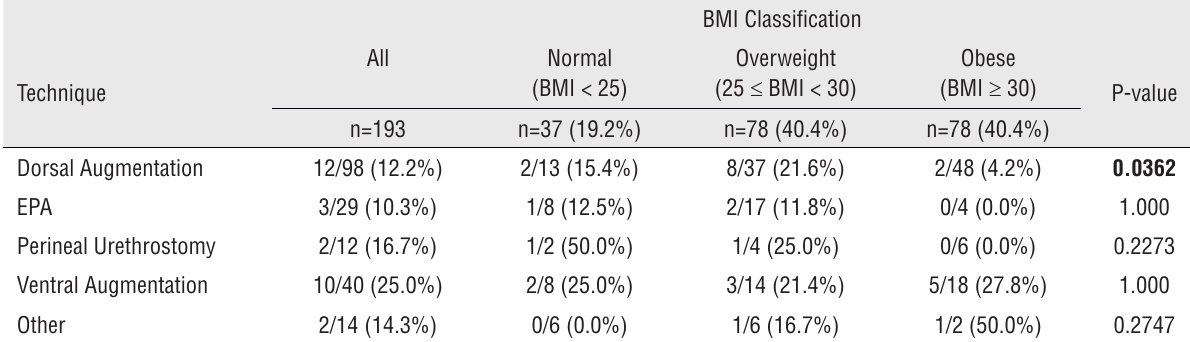
Table 3B - Recurrence by BMI classification and technique.